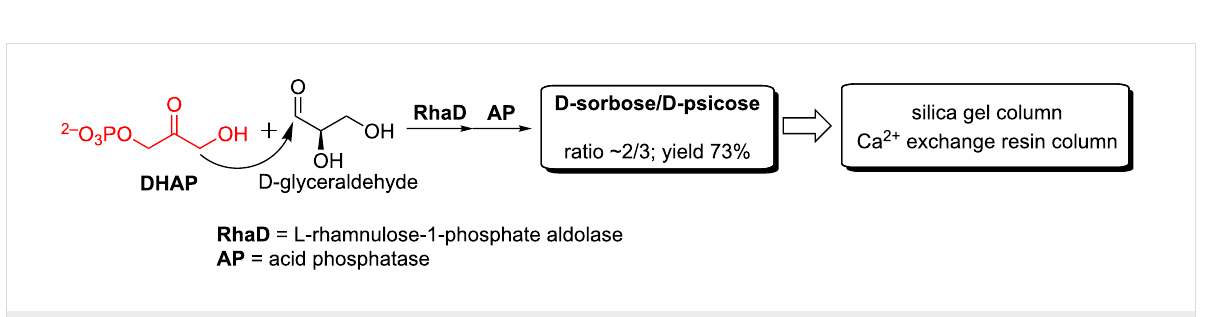
Scheme 5: Simultaneous enzymatic synthesis of D-sorbose and